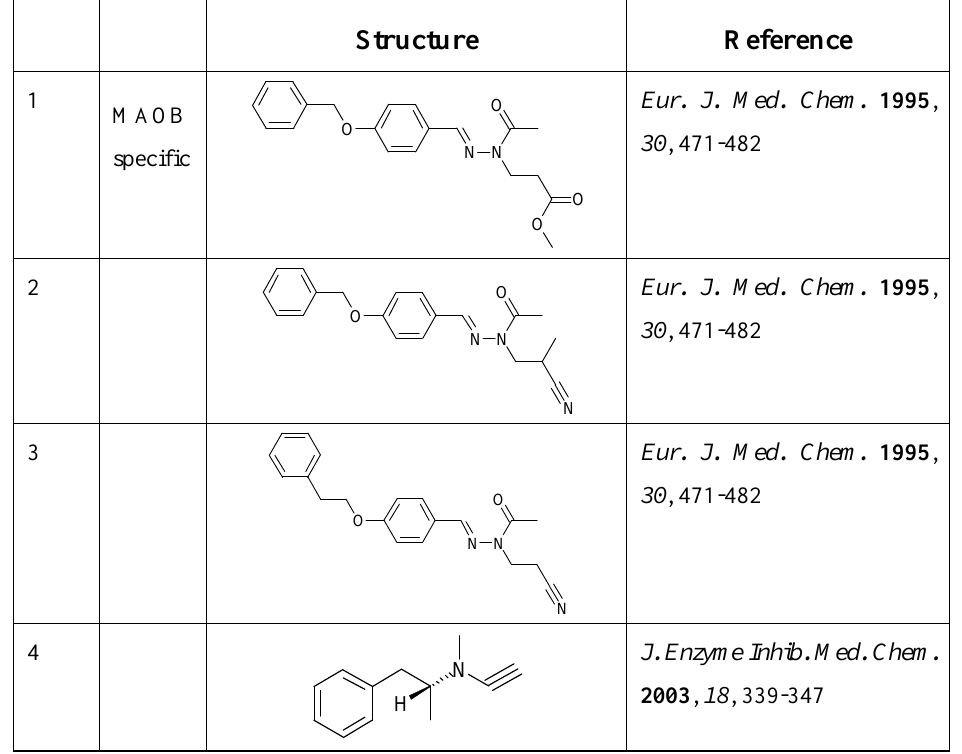
Table S1 : Following table contains the list of compounds and citation used as a database to find out enrichment factor (measure of validation of the